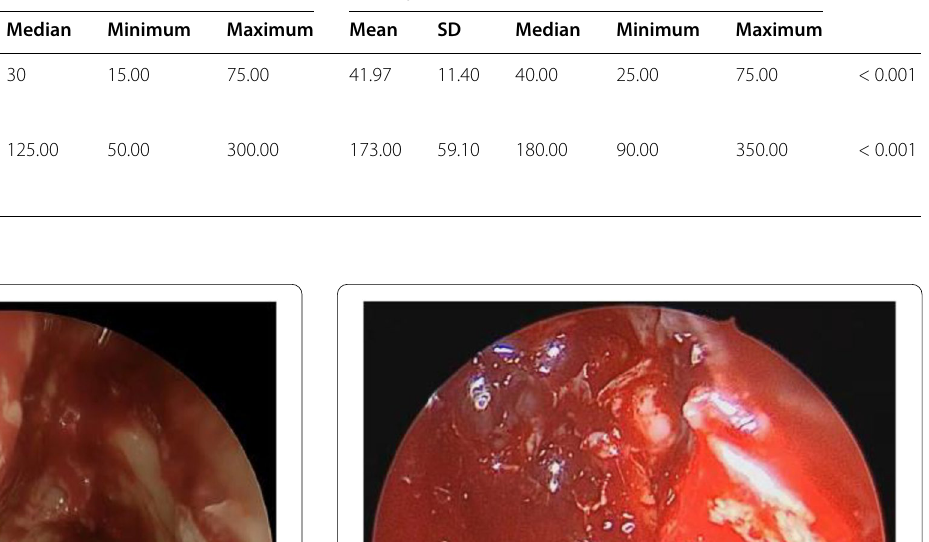
Table 1 Comparison between injected and non‑injected side as regards the amount of bleeding and duration of surgery Injected